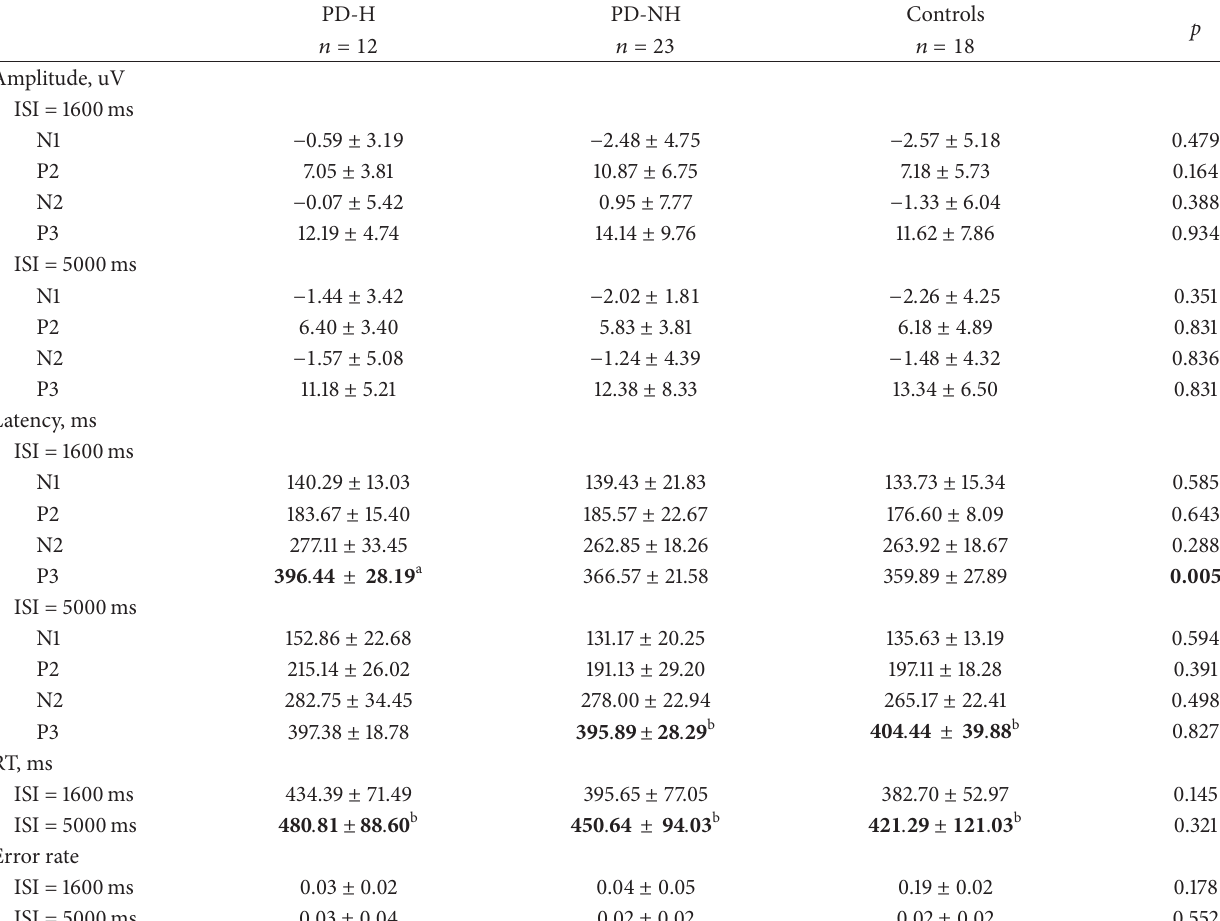
Table 3: Comparisons of latencies and amplitude at Pz in visual ERPs of PD-H, PD-NH, and